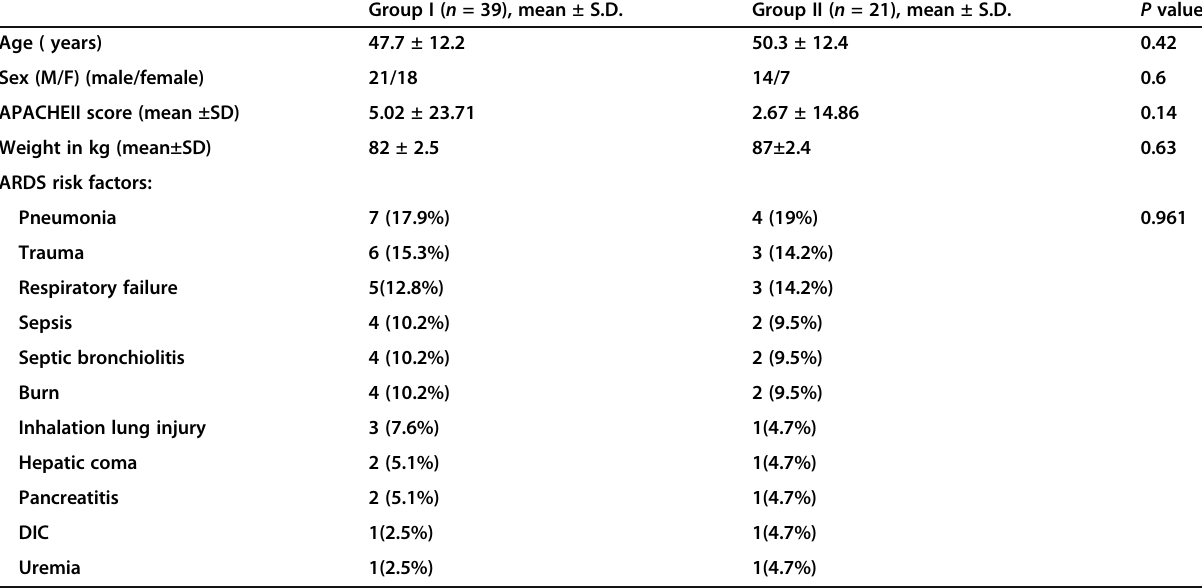
Table 1 Patients characteristics and ARDS risk factors at the day of enrollment Group I ( n = 39), mean ±